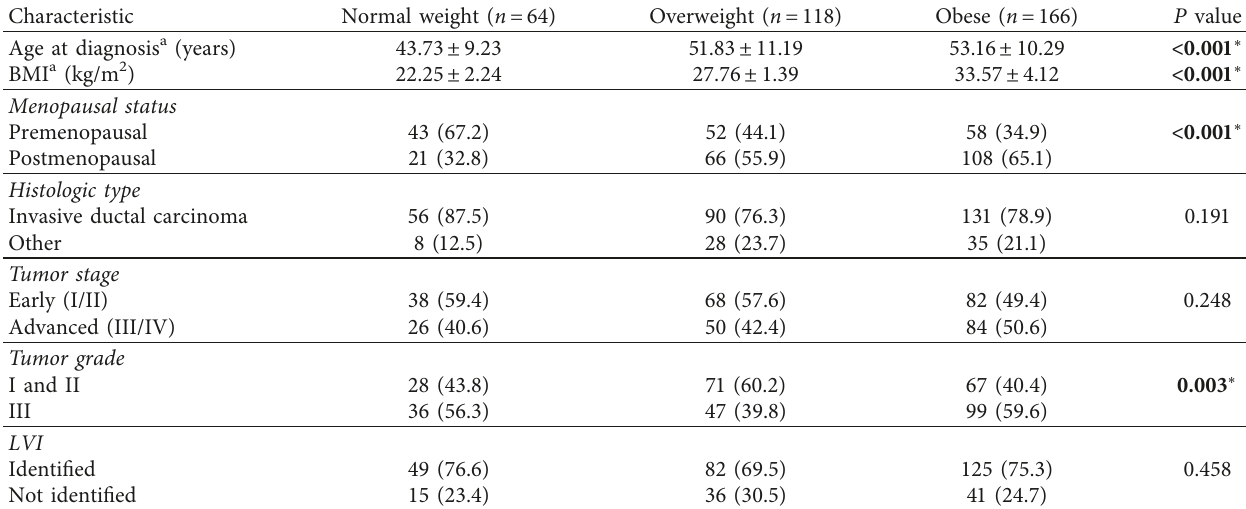
Table 3: Clinicopathologic characteristics of breast cancer patients by BMI category ( N � 348).